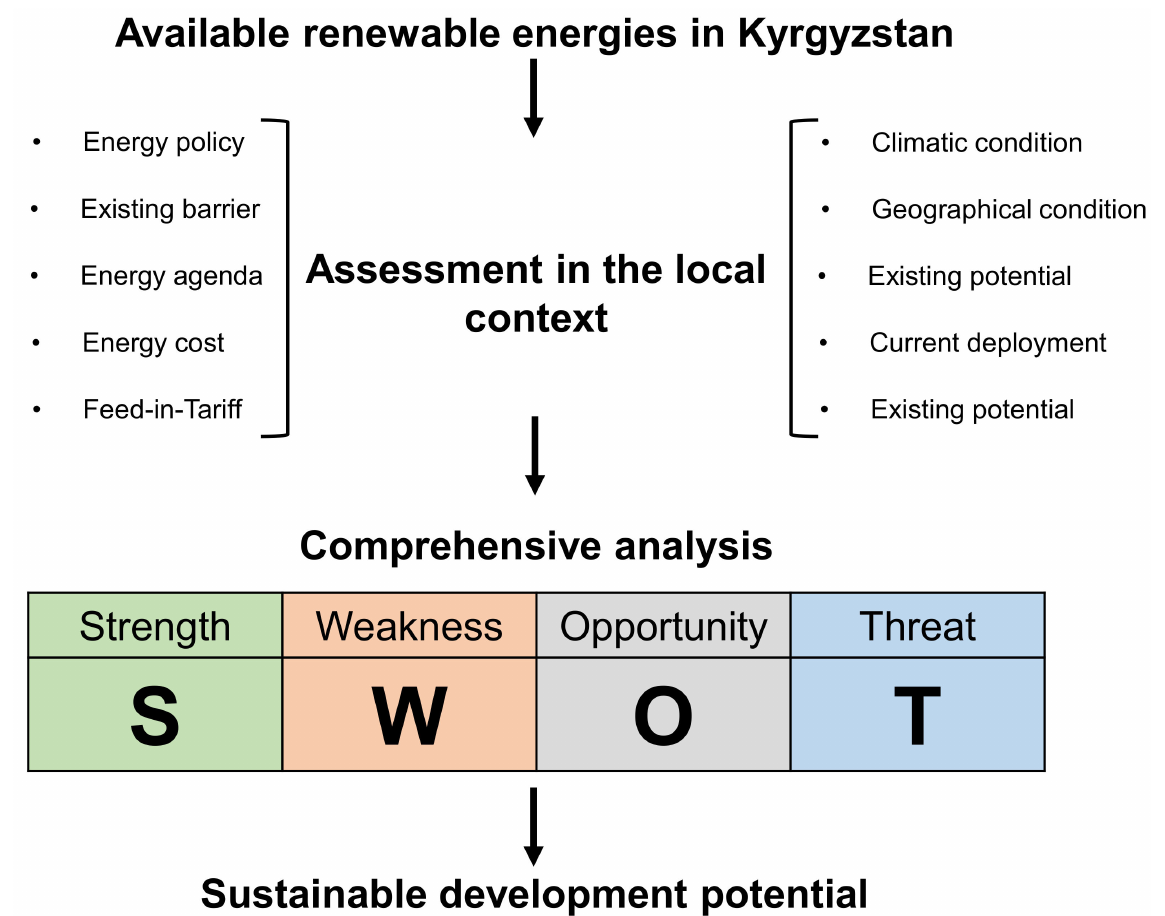
Figure 1. An overview of the research methodology for mapping the presented